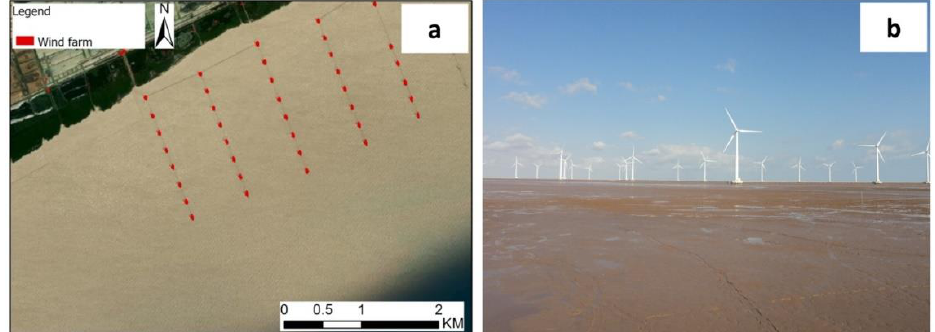
Figure 10. Wind energy farm off the shore of Bạc Liêu ( a ) wind-energy tower map detected from Sentinel-1 SAR and ( b ) ground-truth field photograph on 26 February 2019 at 9°13′49.76′′ N and 105°48′12.12′′ E.